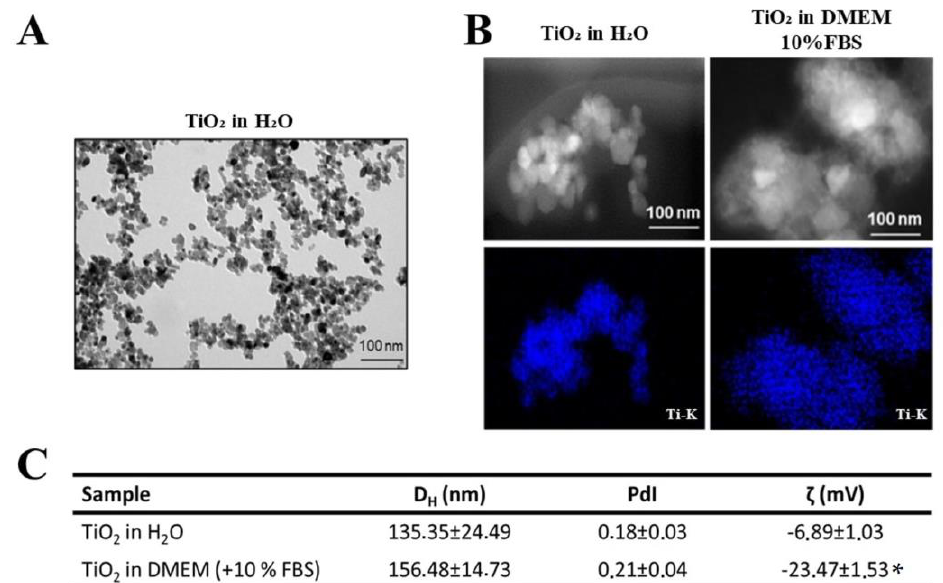
Figure 1. Characterization of TiO 2 NPs: ( A ) Transmission electron micrographs (TEM) of TiO 2 NPs in ultrapure water without dispersion. ( B ) Dark-field STEM micrographs of TiO 2 NPs after dispersion in water and cell culture medium and STEM/EDS Ti-K map confirming titanium presence (in blue). Scale bar: 100 nm. ( C ): Hydrodynamic diameter (D H (nm)) and polydispersity index (PDI) of TiO 2 NPs after dispersion in ultrapure water and cell culture medium obtained by dynamic light scattering (DLS) and analysis of surface charge by zeta potential of TiO 2 NPs ( ζ (mV)) in water and culture medium. The results represent the mean ± standard deviation of three independent experiments performed in triplicate of measurement (* p < 0.05 vs. TiO 2 NPs in water).